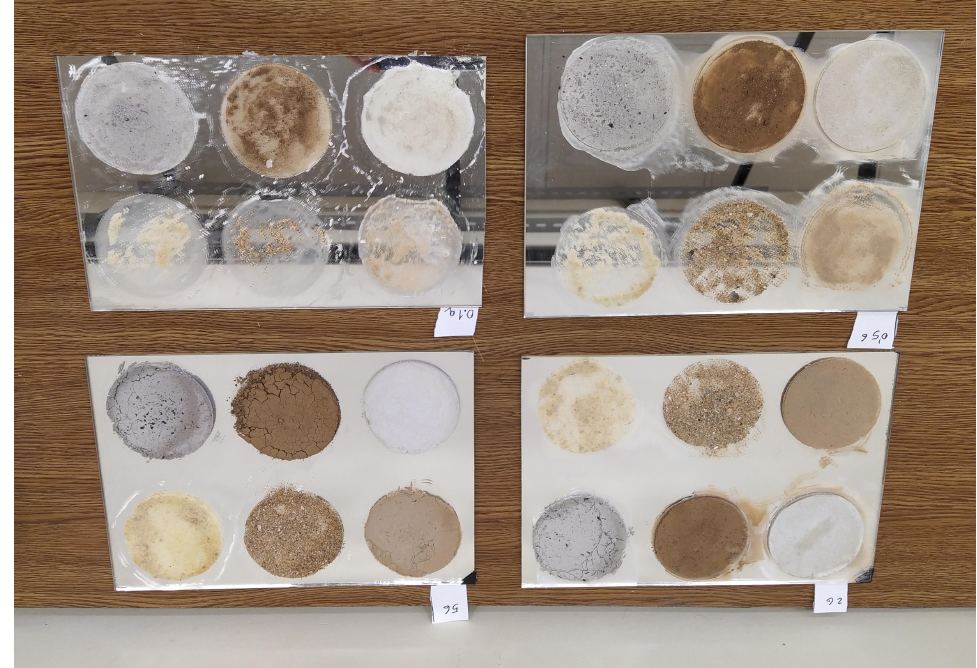
Figure 8. Reflectors polluted with different densities. From left to right and from top to bottom: 0.1g, 0.5g, 5g, 2g. All pollutants were applied in the same order (ash, red soil, cement, limestone, coarse sand and fine sand) except the reflector with 2g, where the first and second row were